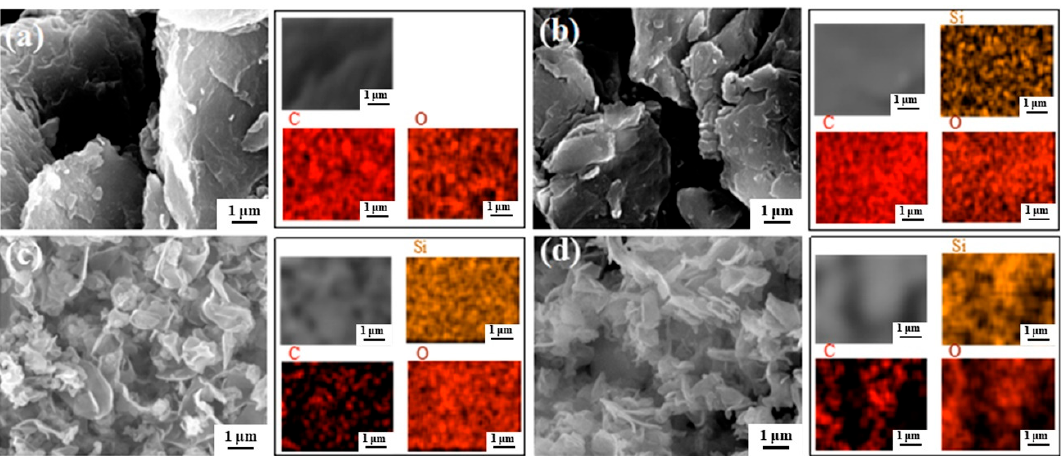
Figure 2. SEM images and corresponding EDX mapping results of C, O, Si for ( a ) GO, ( b ) G-K, ( c ) G-S, and ( d ) G-S-K. Table 1. Element content of GO, G-K, G-S, and G-S-K from EDX results.